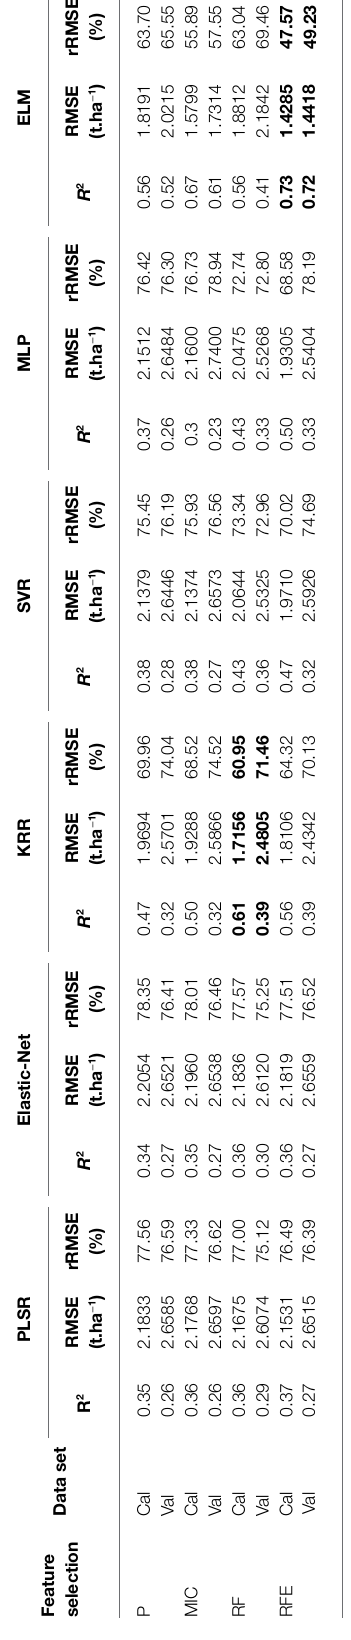
images are the most common type of image in daily life, processing. More and more RGB images have been used for yield monitoring. Although these methods can effectively improve the accuracy of the yield estimation model, there is still room for improvement; for example, Liu et al. (2019) used the vegetation indices extracted from RGB imagery of a rice canopy to estimate its yield. The accuracy R 2 of the model was improved, but only reached 0.7074. Fathipoor et al. (2019) used UAV RGB imagery to estimate forage yield, and the verification accuracy of their estimation model was 0.74, with a relative RMSE of 12.39%. In this paper, the RFE_ELM model was found to be the best model to estimate the yield through the use of vegetation indices, with R 2 = 0.7310, RMSE = 1.4285, and rRMSE = 47.57% on the training set, and R 2 = 0.7244, RMSE = 1.4418, and rRMSE = 49.23% on the verification set, similar to the results of (Huang et al., 2016), who used UAV RGB imagery to extract plant height and count the number of cotton bolls to estimate cotton yield. However, the accuracy was significantly lower than that of the cotton yield monitoring model established by Feng et al. (2020) using multi-sensor imagery. In this paper, the vegetation indices extracted from the UAV RGB imagery were significantly correlated with the cotton yield, such that it is feasible to select the optimal parameter features for cotton yield monitoring; however, this still needs to be improved from the perspective of model accuracy. Therefore, more texture feature information or other color information should be mined from RGB imagery, to improve model accuracy. Texture features are an important parameter of RGB imagery, for which there exist many extraction methods. GLCM is the most commonly used and effective extraction method. In this paper, GLCM was used to obtain four texture features at different angles (0 ° , 45 ° , 90 ° , and 135 ° ). Figure 2 shows that different cotton canopy grey values in the RGB imagery were used to extract texture features, some of which had significant correlations with cotton yield, where the difference had a significant correlation between different perspectives on the same parameters, namely according to different cotton canopy RGB image texture feature dependencies. This differed from the results of Zhang et al. (2017), in their study on satellite remote sensing texture feature extraction, and those of Zheng et al. (2020), who estimated nitrogen content in rice leaves by using an unmanned aerial vehicle to obtain multispectral images. As shown in Supplementary Figure 2 , as we used a UAV with a flying height of 10 meters to capture high-resolution RGB images, no significant difference was found between each pixel, and we could select the ROI in an image, under the T A